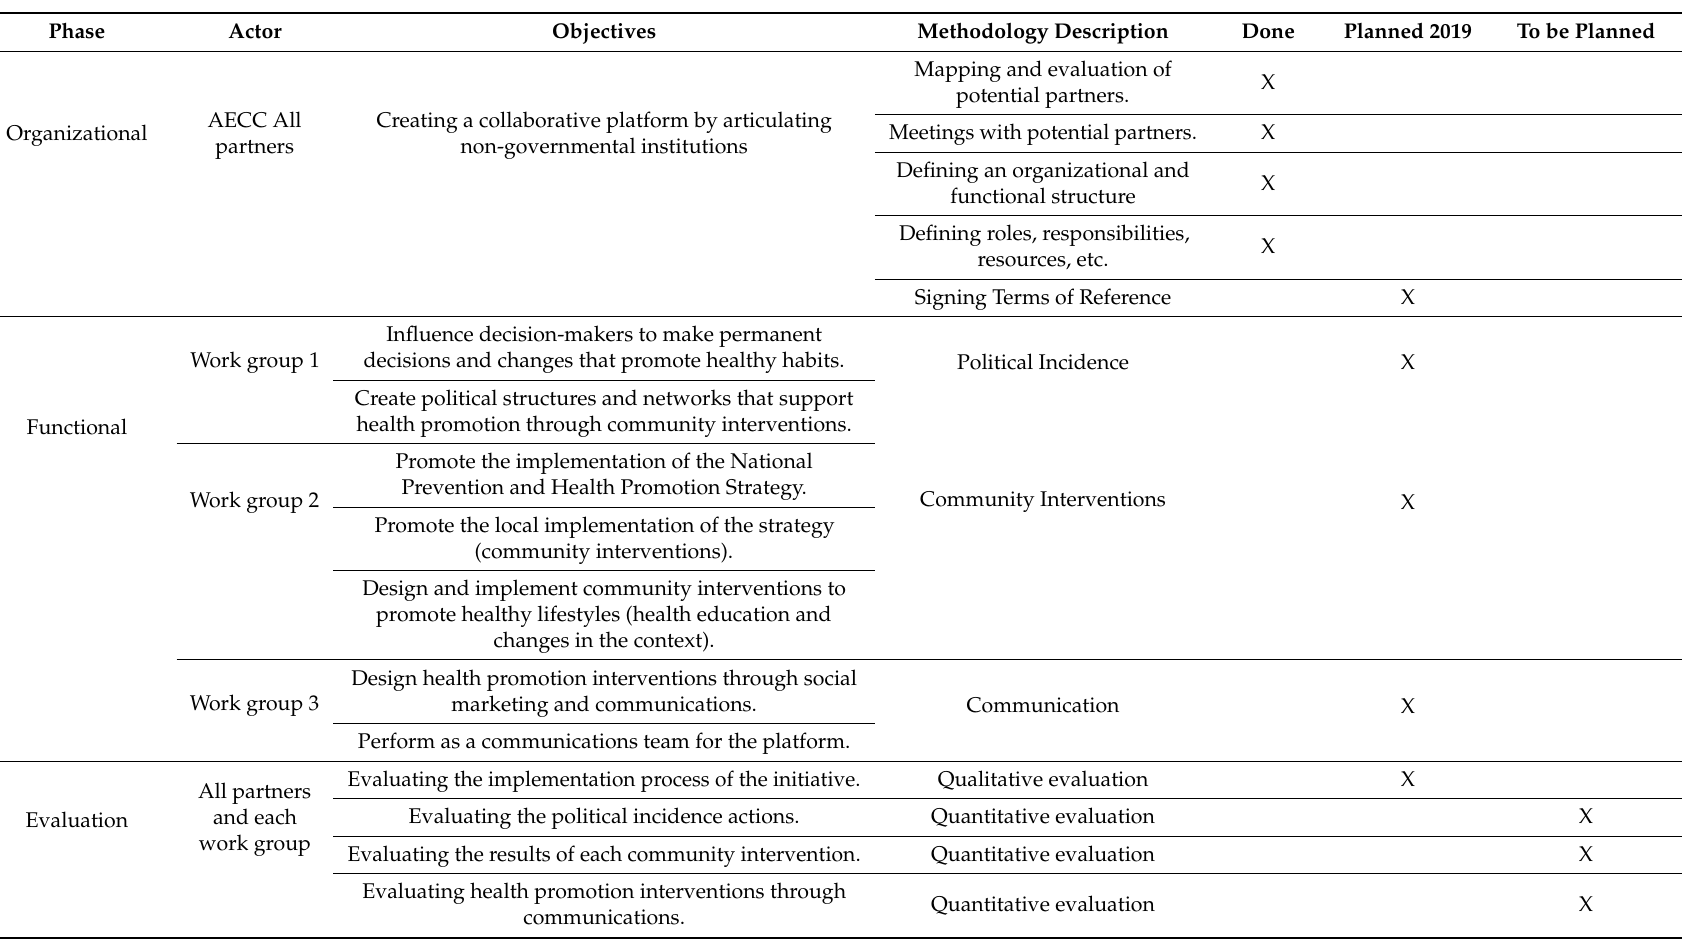
Table A1. Phases, actors, objectives, methodology description of the whole initiative. What is done and what is going to